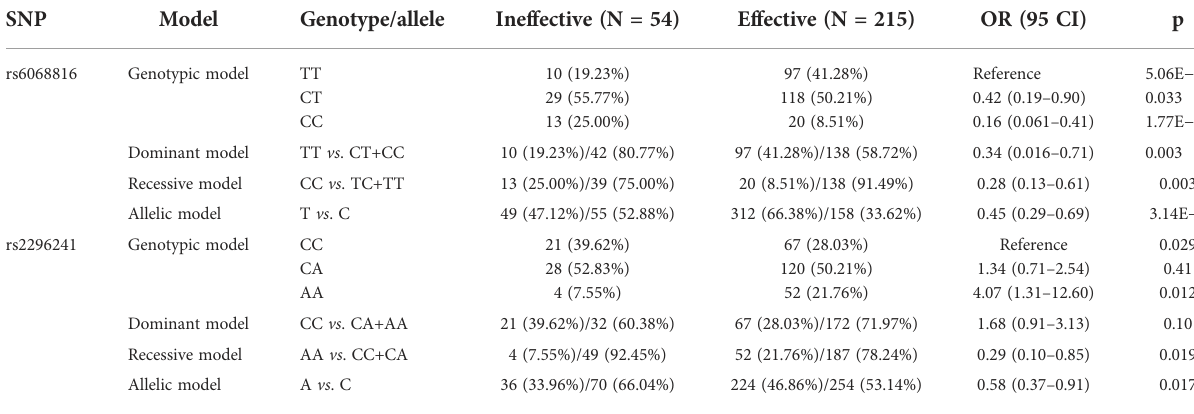
TABLE 4 SNPs signi fi cantly associated with treatment ef fi